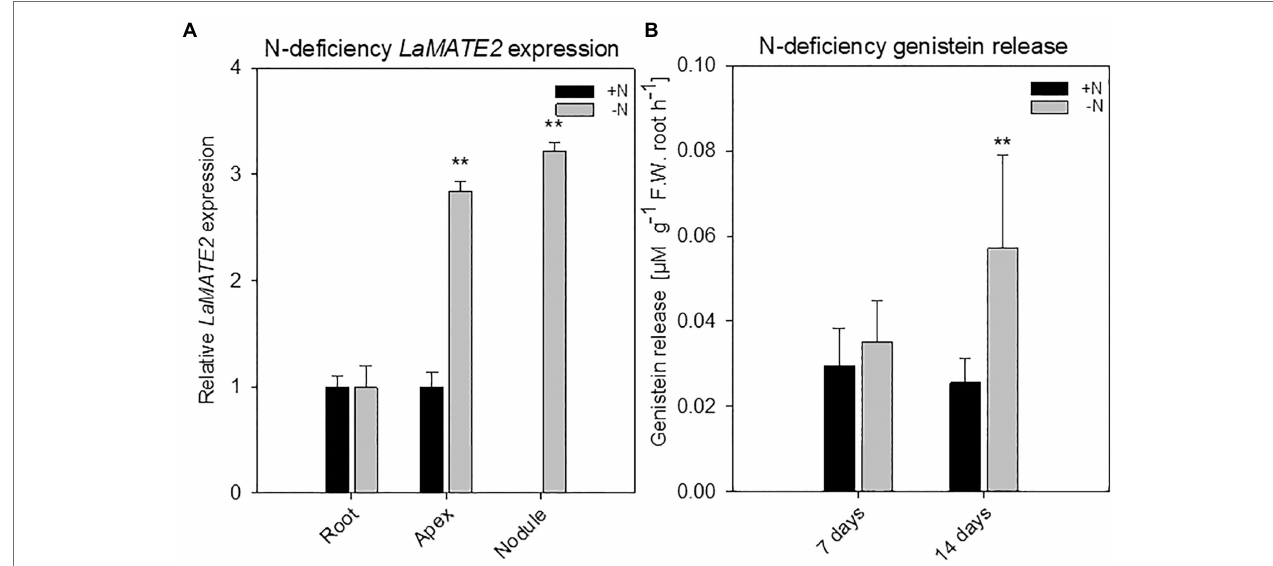
FIGURE 2 | LaMATE2 expression analyses and genistein release in roots of N-deficient white lupin. LaMATE2 expression analyses in white lupin grown under control (+N + P, black bars) condition or after 2 weeks of N-deficiency (-N + P, dark grey bars) (A) . Gene expression was evaluated in control and N-deficient (other) root, root apex and nodules. Expression level is shown relative to LaMATE2 expression in control (+N + P) root. Root release of genistein from white lupin plants grown under 1- or 2-week-old N-sufficient and -deficient condition (B) . Genistein release in 7 and 14 days of N deficiency (-N + P) or sufficiency (+N + P). Data are mean + SD (Asterisks refers to statistically significant differences among the mean value of the sample vs control, ANOVA Holm–Sidak, N = 6–8, ** p < 0.01; with 3 technical replicates for each real-time